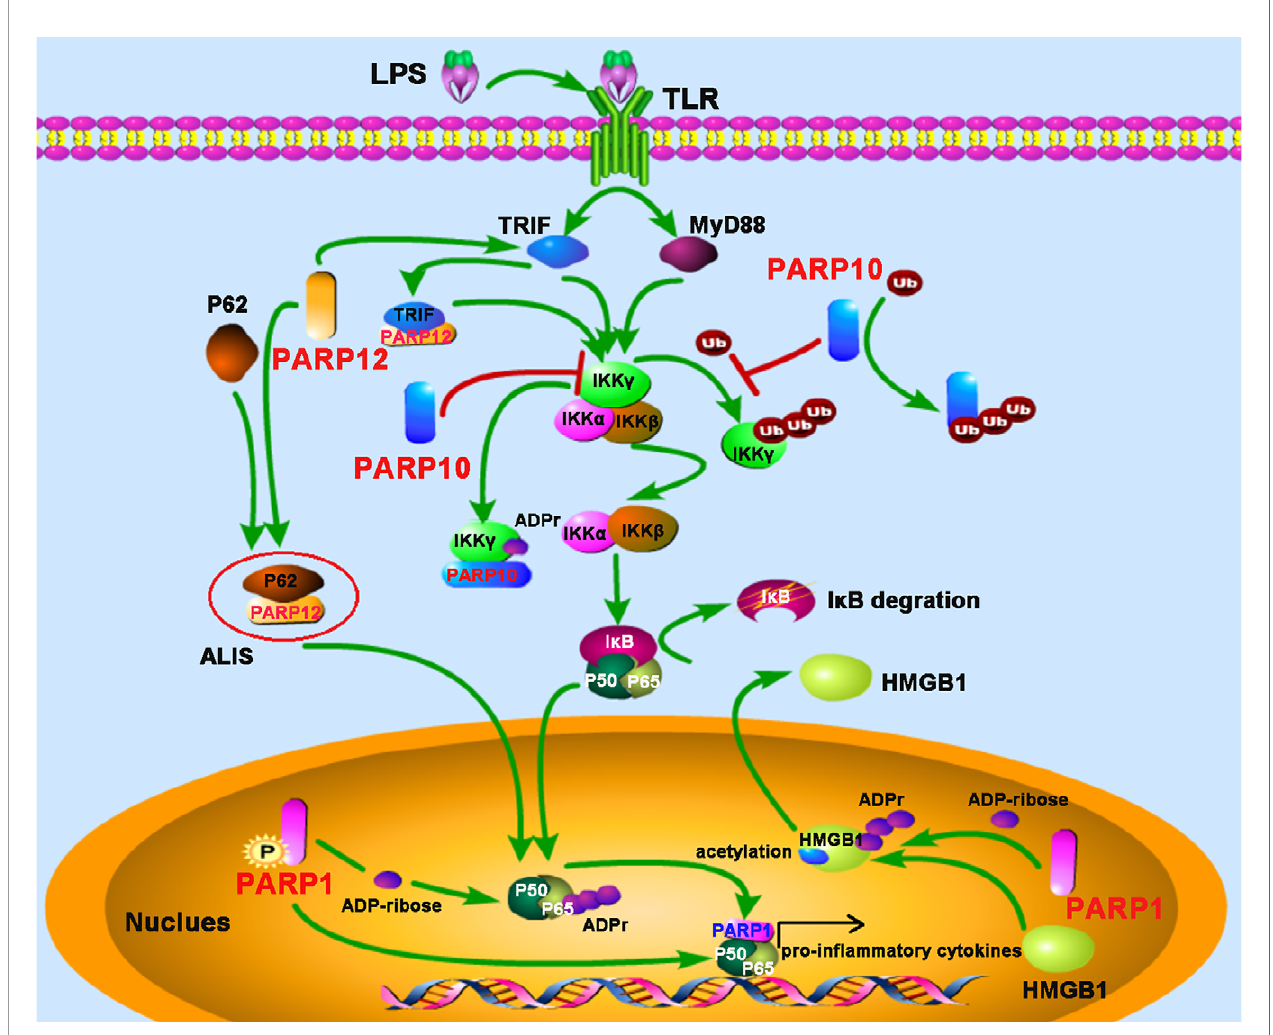
FIGURE 3 | PARPs regulate the NF- k B-mediated in fl ammatory responses. LPS stimulates the activation of the NF- k B signaling pathway depending on TRIF (toll- receptor-associated activator of interferon) and MyD88 (myeloid differentiation factor 88). PARP12 is recruited and co-localized with p62 in the aggresome-like induced structures (ALIS), which acts as a platform for NF- k B signaling; PARP12 interacts and co-localizes with TRIF, leading to an enhancement of NF- k B signaling. PARP10 inhibits the activation of IKK g through two mechanisms: competitively binding of K63-polyubiquitination to interfere with IKK g ’ s polyubiquitylation and interacting with IKK g to promote its mono-ADP-ribosylation, leading to the inhibition of p65 translocation into the nucleus. The phosphorylation of PARP1 results in the PARylation of the NF- k B subunit p65. The direct interaction with both subunits of NF- k B (p50 and p65) by PARP1 promotes NF- k B-inducible cytokine production. PARP1 mediates the PARylation of high-mobility group box 1 (HMGB1), following by subsequent acetylation, and then induces its release from the nucleus to the